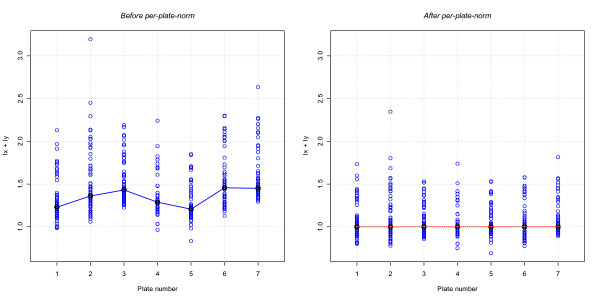
Per-plate intensity normalization. An example of how per-plate normalization can improve data quality. After this normalization step the plate intensity distributions follow a more similar pattern.